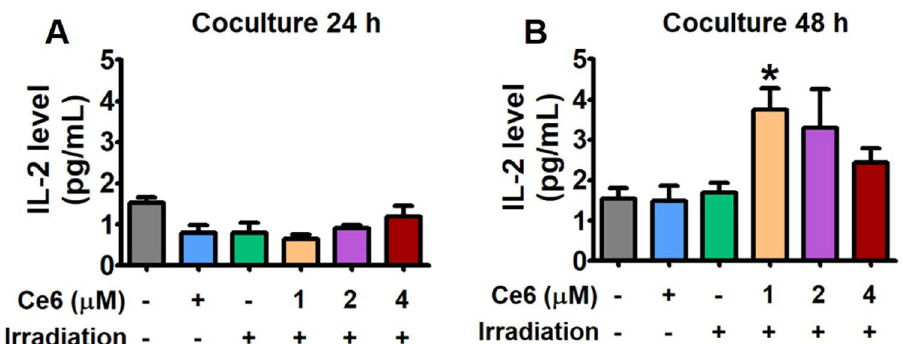
Figure 7. Effect of Ce6-PDT on IL-2 cytokine release in Jurkat T cells and MC38 colon cancer cells coculture model. Cell culture media was analyzed to measure IL-2 level by cytokine ELISA in ( A ) 24 and ( B ) 48 h. The concentration of Ce6 only is 4 μΜ. Data are presented as mean ± S.E. of three representative independent experiments. * P < 0.05 compared to vehicle-treated control. (by one-way ANOVA with Tukey’s post hoc test for multiple comparisons).